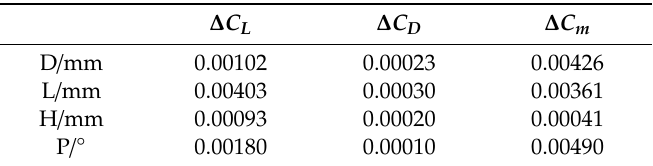
Maximum interference di ff erence of the V-shaped support geometric parameters ( Ma = 0.75, α = 0 ◦